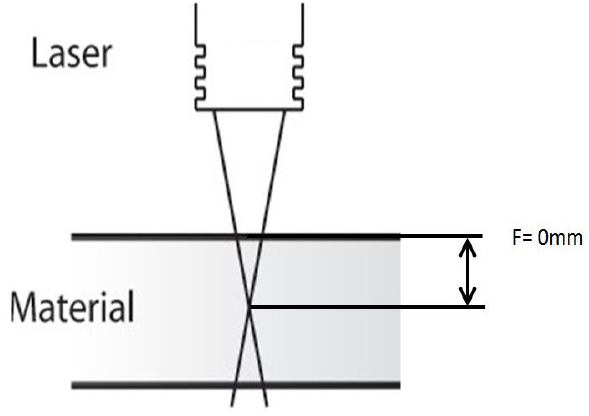
Figure 1. Focal position and its impact on the energy density at the surface, depending on the focal length.